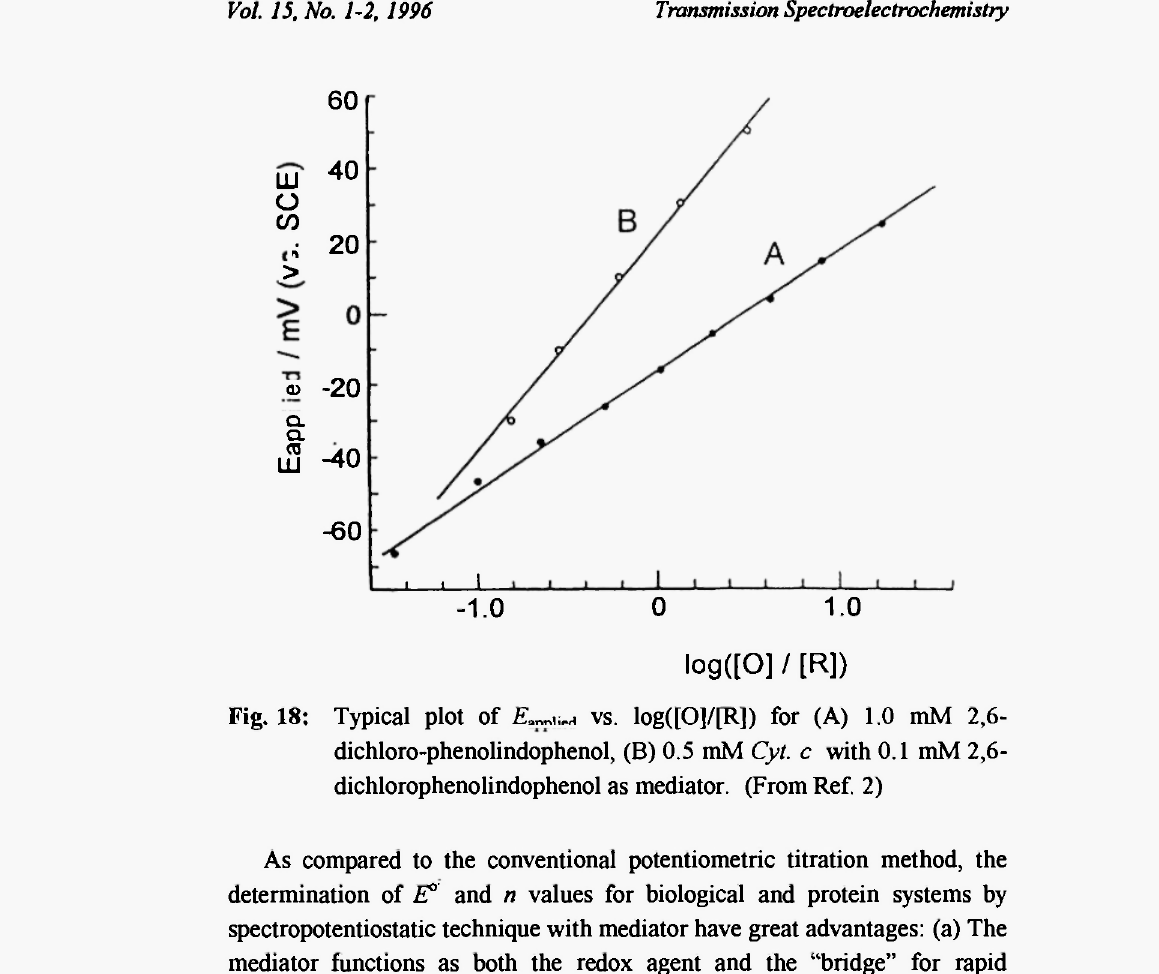
Fig. 18: Typical plot of vs. log([0]/[R]) for (A) 1.0 mM 2,6- dichloro-phenolindophenol, (B) 0.5 mM Cyt. c with 0.1 mM 2,6- dichlorophenolindophenol as mediator. (From Ref.